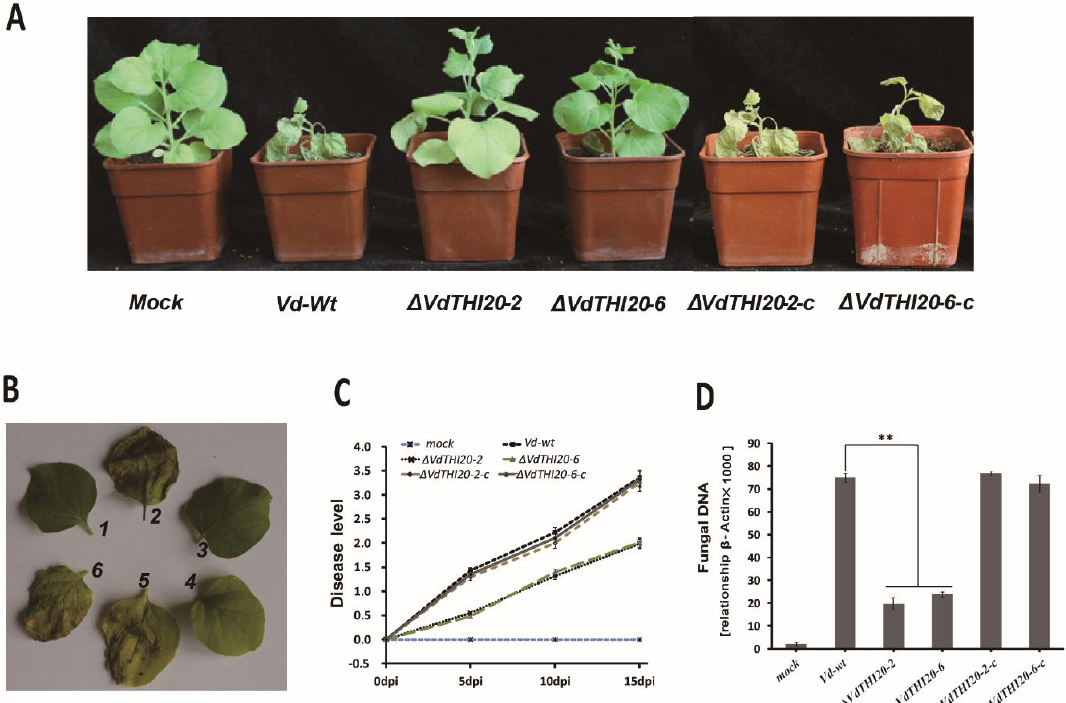
Figure 7. Virulence analysis of the Vd-wt strain, ΔVdTHI20 mutant strains ( ΔVdTHI20-2 and ΔVdTHI20-6 ), and complemented ∆VdTHI20 mutant strains ( ΔVdTHI20-2-c and ΔVdTHI20-6-c ) on N. benthamiana . ( A ) Virulence phenotypes of N. benthamiana seedlings at 12 dpi with different V. dahliae strains. ( B ) Representative leaf images of N. benthamiana at 12 dpi with different V. dahliae strains. 1, mock; 2, representative leaf of N. benthamiana infected with the Vd-wt strain; 3,4, representative leaf of N. benthamiana infected with ΔVdTHI20-2 and ΔVdTHI20-6 respectively; 5,6, representative leaf of N. benthamiana infected with ΔVdTHI20-2-c and ΔVdTHI20-6-c respectively. ( C ) Disease level of N. benthamiana seedlings after a 2-min root dpi in a conidial suspension of the different V. dahliae strains at 5, 10, and 15 dpi. ( D ) Fungal DNA concentration in N. benthamiana hypocotyls with different V. dahliae strains at 12 dpi. N. benthamiana seedlings inoculated with tap water (mock) as a control. The difference of fungal DNA concentration between the ΔVdTHI20 mutant strains and the Vd-wt strain is significant. The difference of fungal DNA concentration between the complemented ∆VdTHI20 mutant strains and the Vd-wt strain is not significant. Values represent the mean ± standard deviation from three independent replicates. Asterisks (**) indicate significant differences by Student’s t test at P < 0.01.